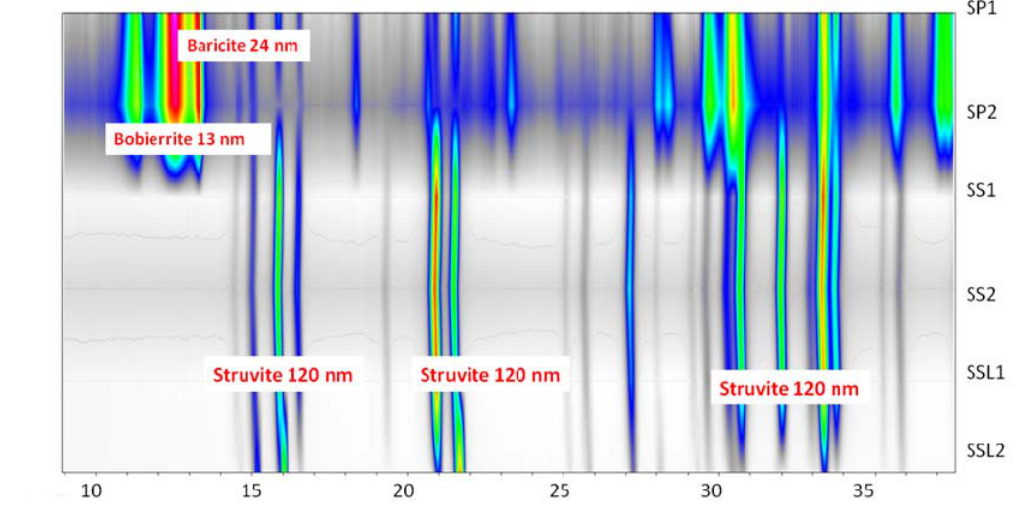
Figure 4. Map drawn from X-ray diffraction (XRD ) p atterns. Colors in the map indicate the changing intensity of the diffracted X-rays as a function of 2, with warmer colors for progressively higher